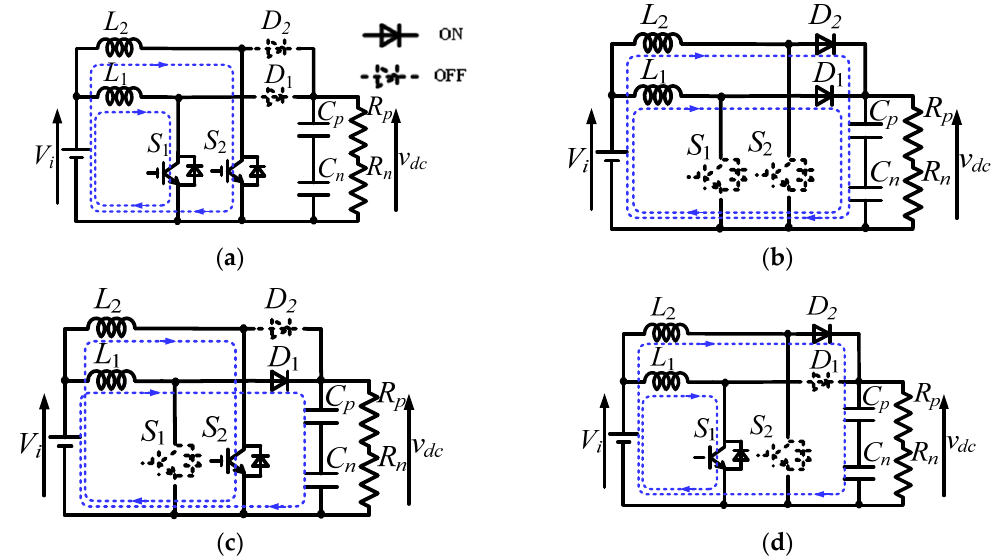
Figure 4. Switching modes of parallel circuit. ( a ) MODE1; ( b ) MODE2; ( c ) MODE3; ( d ) MODE4.